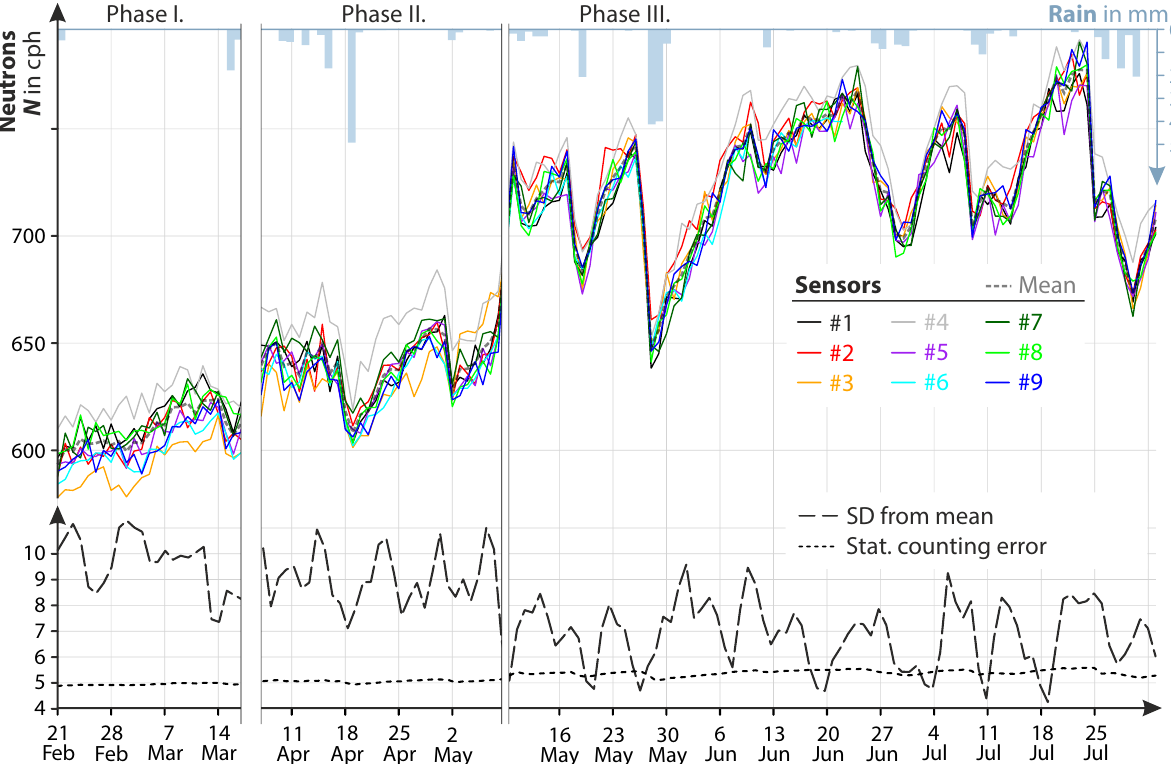
Figure 3. Time series of nine sensors covering phases I (installation), II (permutation), and III (calibration) in year 2014. By removing detector-specific effects in Phase III, the standard deviation (SD) of the sensor ensemble from their mean could be reduced down to the statistical error of σ ≈